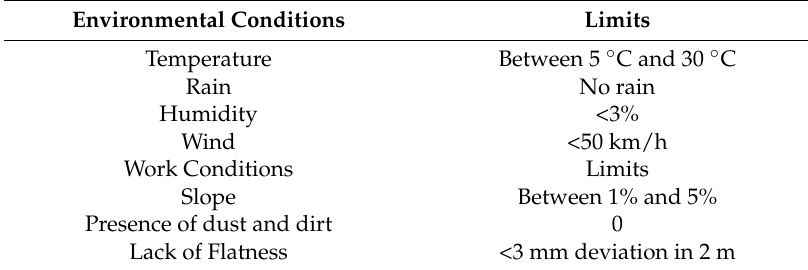
Table 3. Sensorized variables and acceptable intervals in the